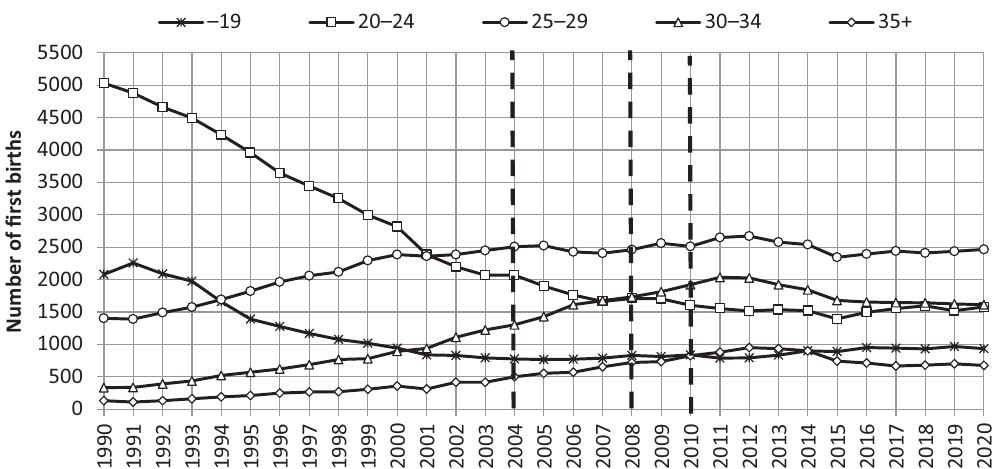
Figure 6. First births by childless women by age in Slovakia in 1990–2020. Source: Author’s calculations based on Statistical Office of the Slovak Republic (1992–2020, 2021a). Note: The dashed lines represent the years of the adoption of the most important changes in family policy